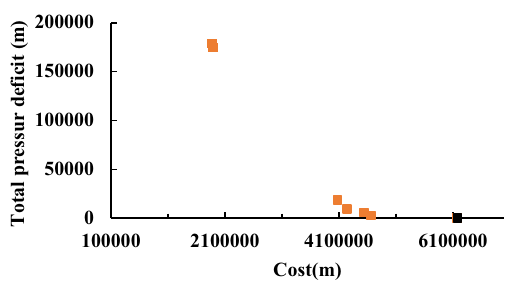
Fig. 5 Front of non-dominant solutions of three-loop no-leak